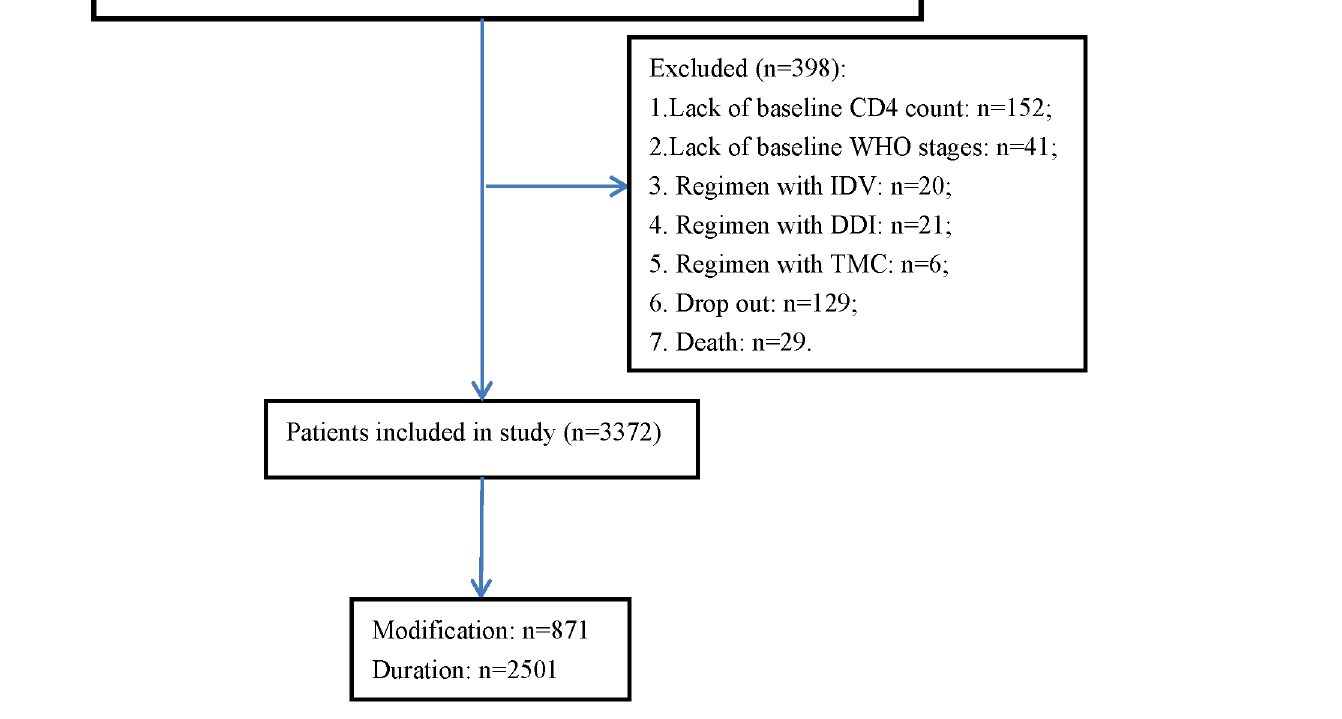
Fig 1. Patient selection